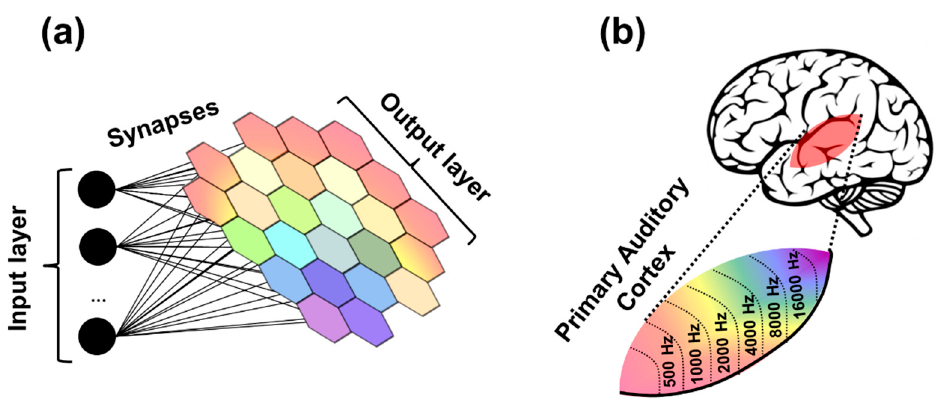
Figure 3. ( a ) Example of a self-organizing map. ( b ) An example of a topological map in the human brain, corresponding to the tonotopic map of the primary auditory cortex.